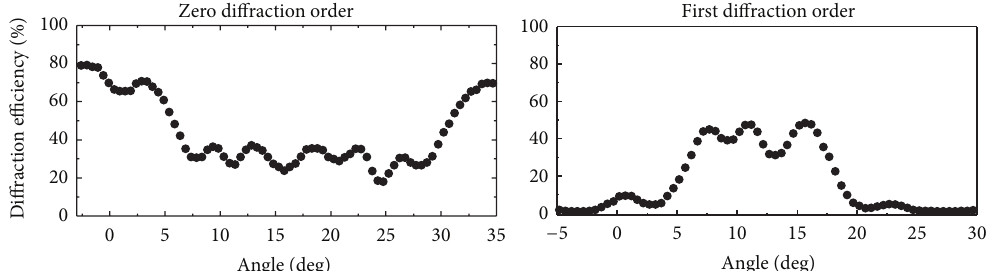
Figure 4: Angular selectivity curves for range of combined lens elements recorded with the exposure energy of 60 mJ/cm 2 at spatial frequency of 300